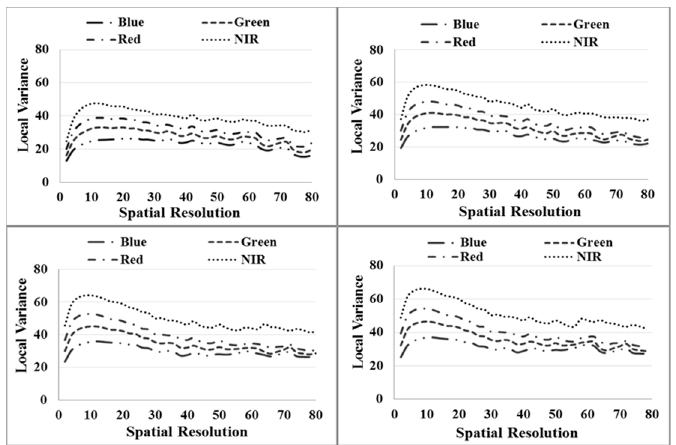
Figure 3. Local variance plots of PMF in Jizhou.